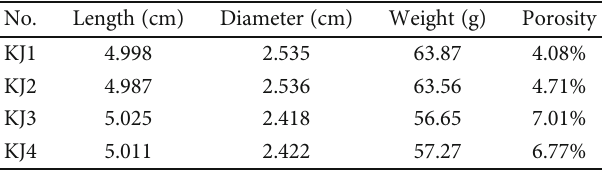
(b) Schematic diagram of the fractured sample (c) End surface of the fractured sample Figure 2: The intact and fractured samples. Table 1: The parameter values of